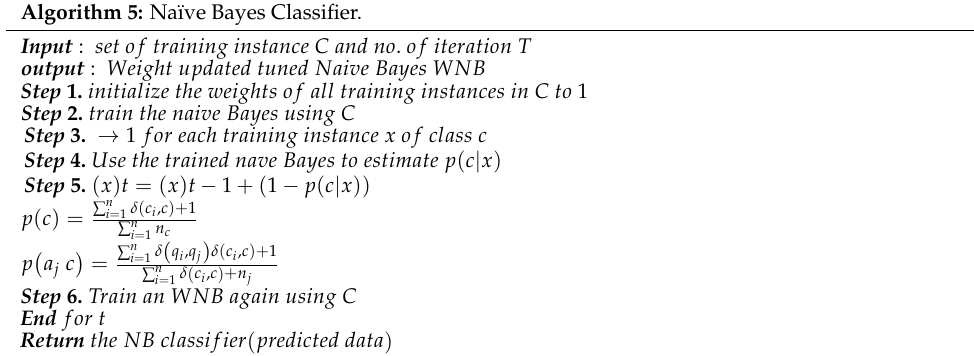
Algorithm 5: Naïve Bayes